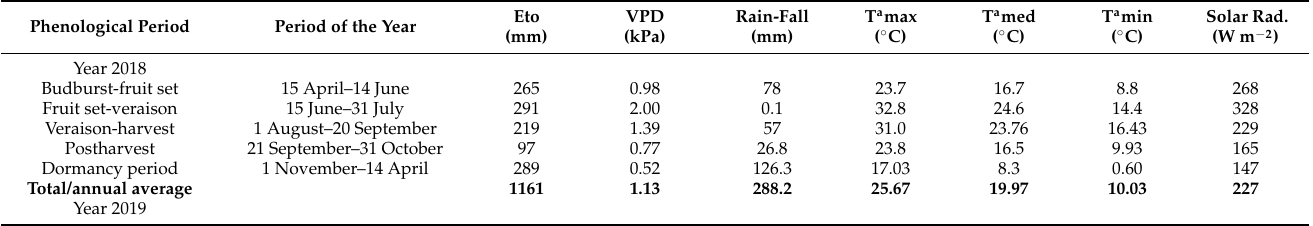
Table 1. Mean values of several climatic parameters in different phenologial periods for every year of the experiment in the study